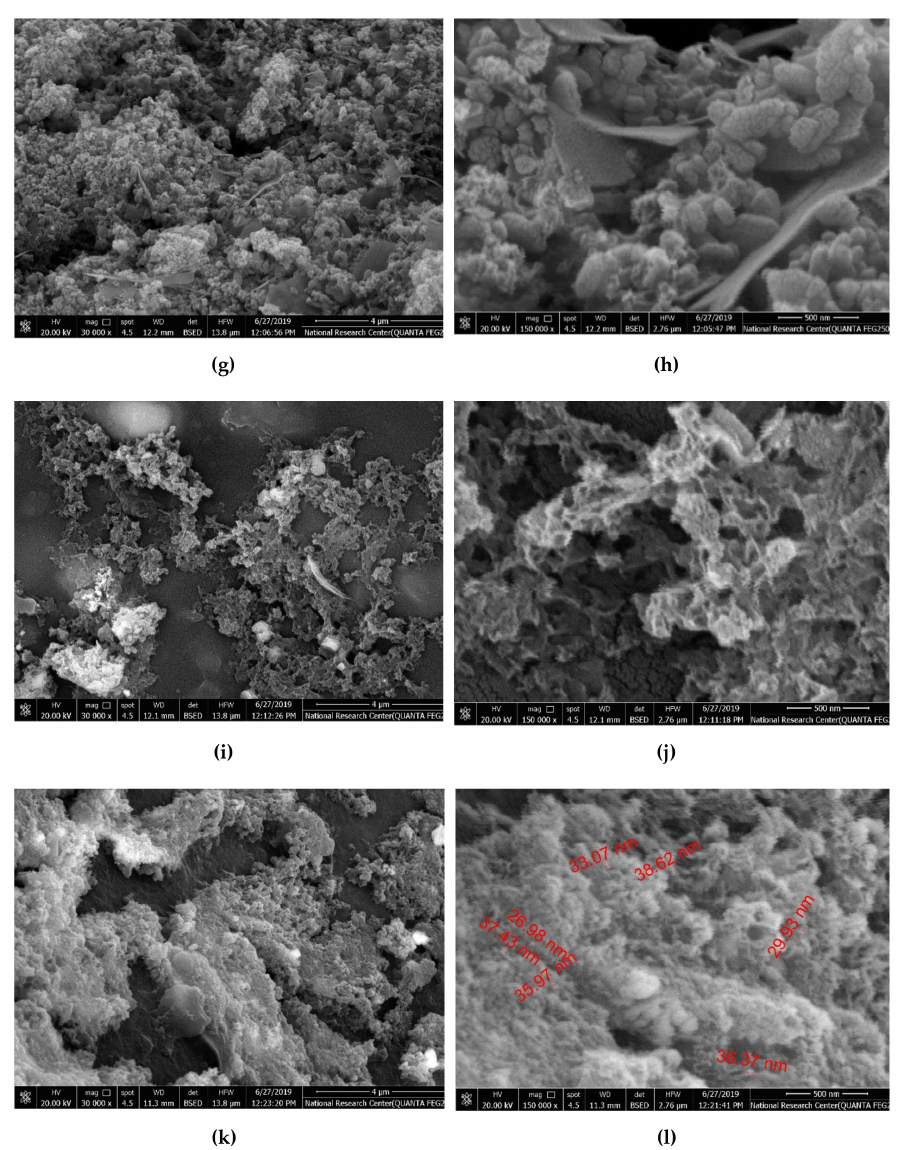
Figure 6. SEM images of bare AC ( a , b ), Ag / AC ( c , d ), ZnO / AC ( e , f ), ZnO / Ag / AC ( g , h ) Ag / ZnO / AC ( i , j ), and Ag-ZnO / AC ( k , l ) at two di ff erent magnifications for each